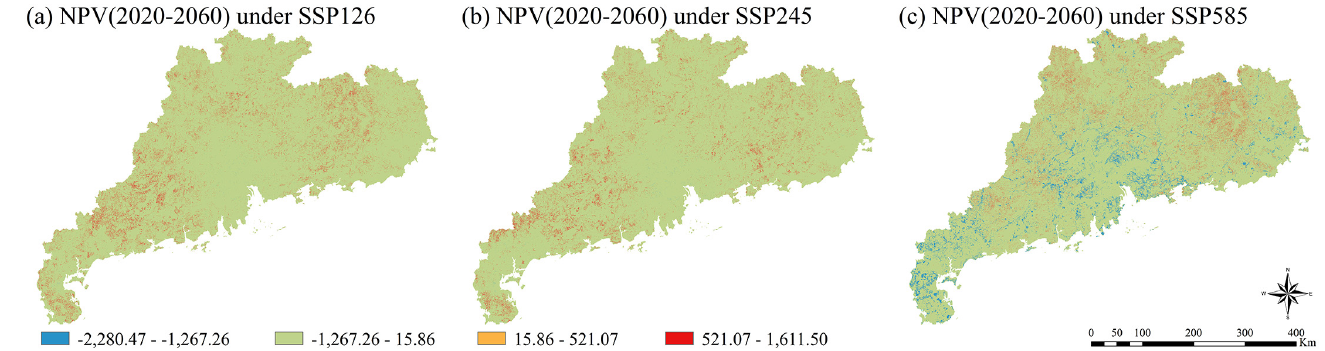
Figure 8. Net present value (unit: RMB) of Guangdong province in the period of 2020–2060 under different scenarios.